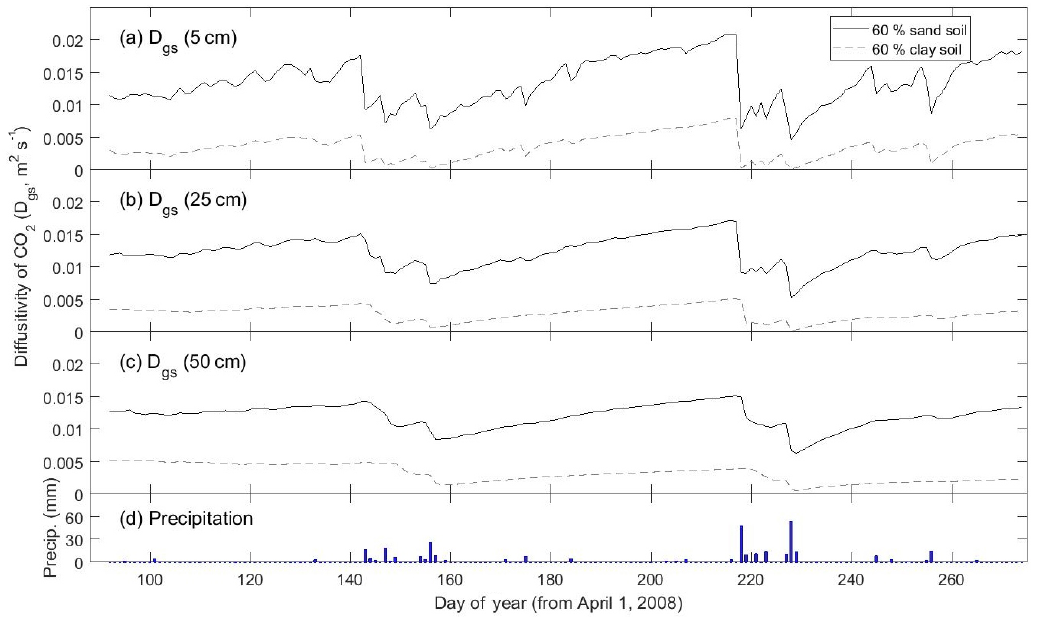
Figure 6. Time series of how the modeled diffusivity of CO 2 ( D gs ) at three different depths (5, 25, and 50cm) varies between a predominantly sandy soil (solid line) and a predominantly clay soil (dashed line). Predictions are from the non-steady state (DETECT) model for the Ctrl (60% sand) and ST-Cl (60% clay) scenarios; see Table 2 for a description of the